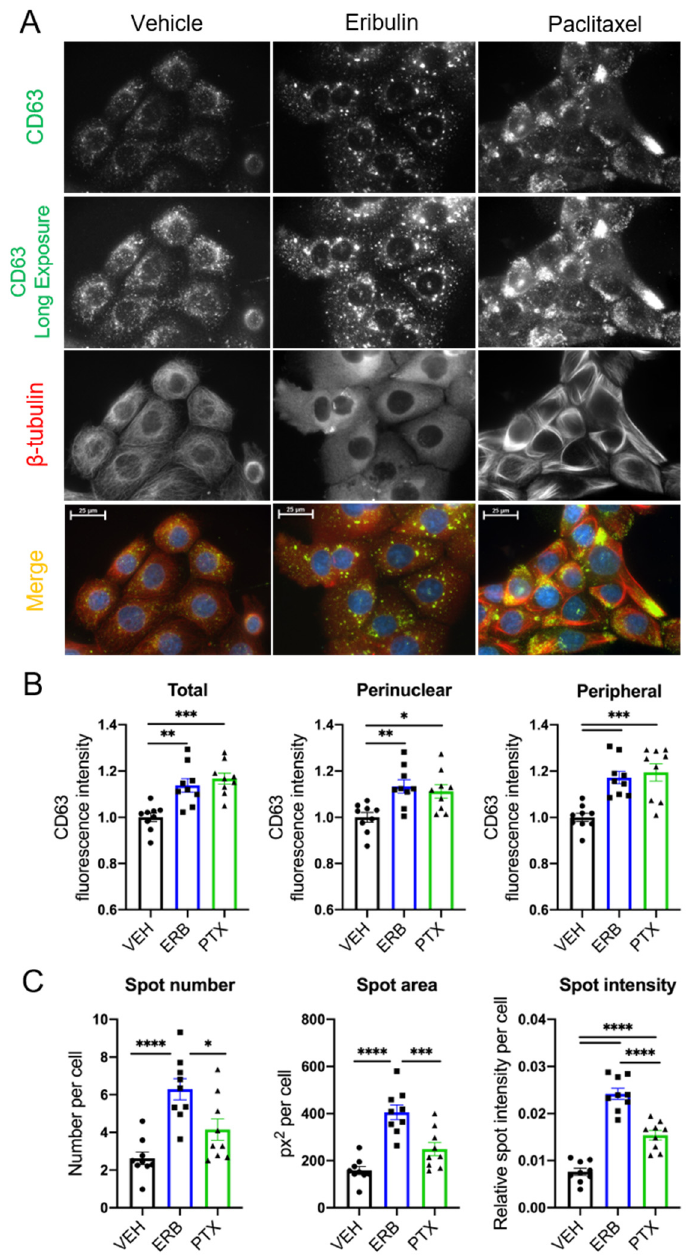
Figure 1. Effects of eribulin or paclitaxel on CD63 localization in HCC1937 cells. HCC1937 cells were treated with vehicle (VEH), 50 nM eribulin (ERB), or 500 nM paclitaxel (PTX) for 4 h to cause maximal microtubule disruption and then co-immunostained for CD63 (green) and β -tubulin (red). ( A ) Immunofluorescence images are representative of two experiments with equal exposures across conditions. Scale bar = 25 µm. ( B ) Quantification of CD63 regional intensity and ( C ) CD63 spots analysis using Operetta™ high-content imaging. Mean cellular fluorescence for a mean of 432 cells (range: 109–1265) was calculated for n = 9 wells and represents three independent experiments. Significance determined by one-way ANOVA with Tukey’s post-hoc test. * p <